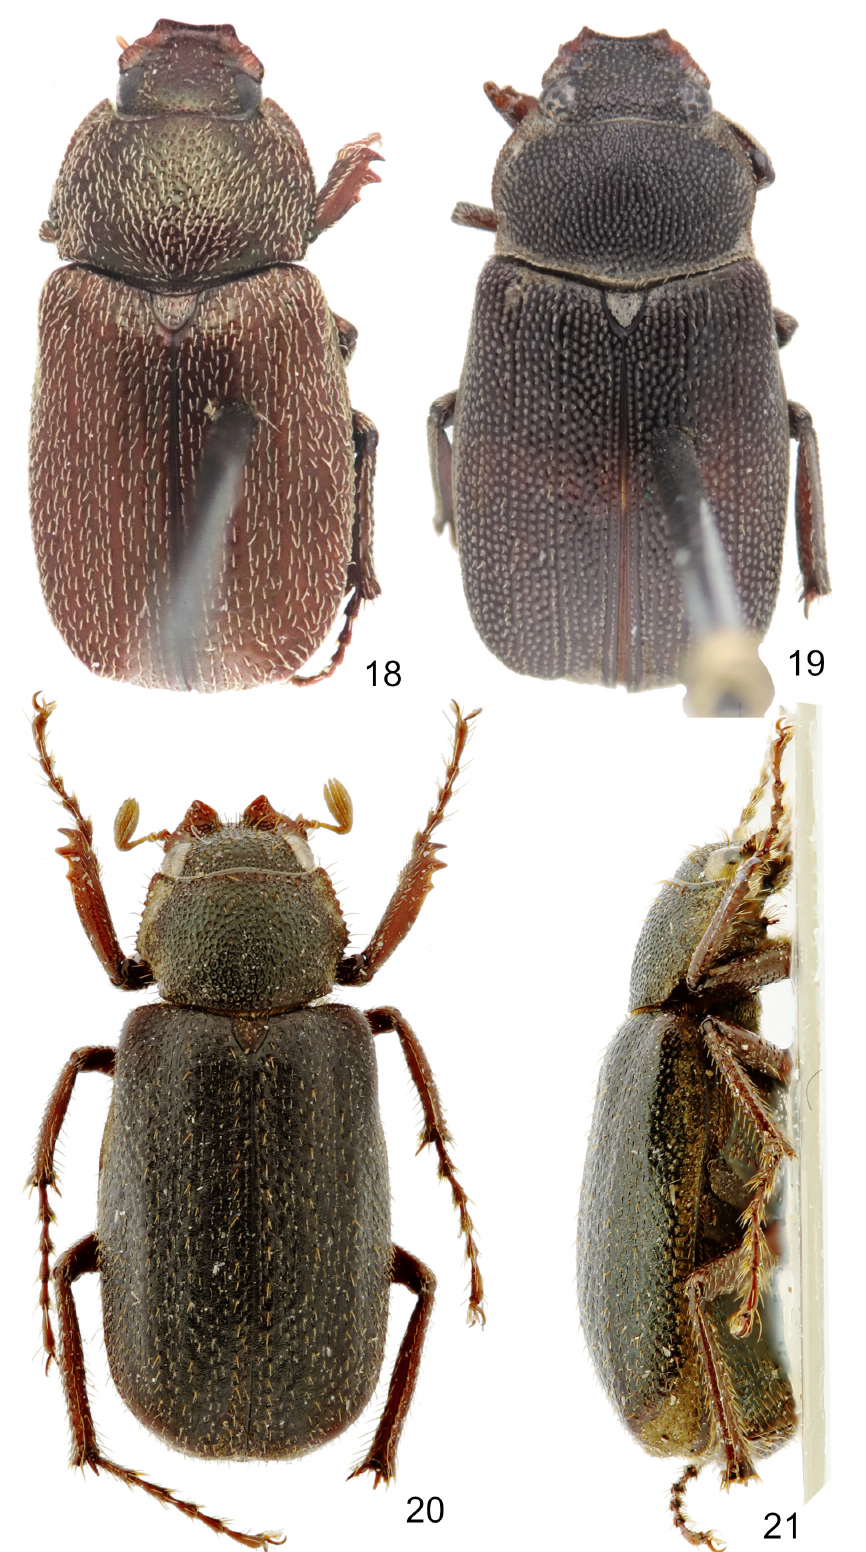
Figs 18–21. Papuan Maechidius Macleay, 1819, habitus, dorsal and lateral views. 18 . M. aenescens Heller, 1910, lectotype, ♀ (SNSD). 19 . M. aiyura sp. nov., holotype, ♂ (BMNH). 20–21 . M. alesbezdeki sp. nov. ♂ (NME). Not to